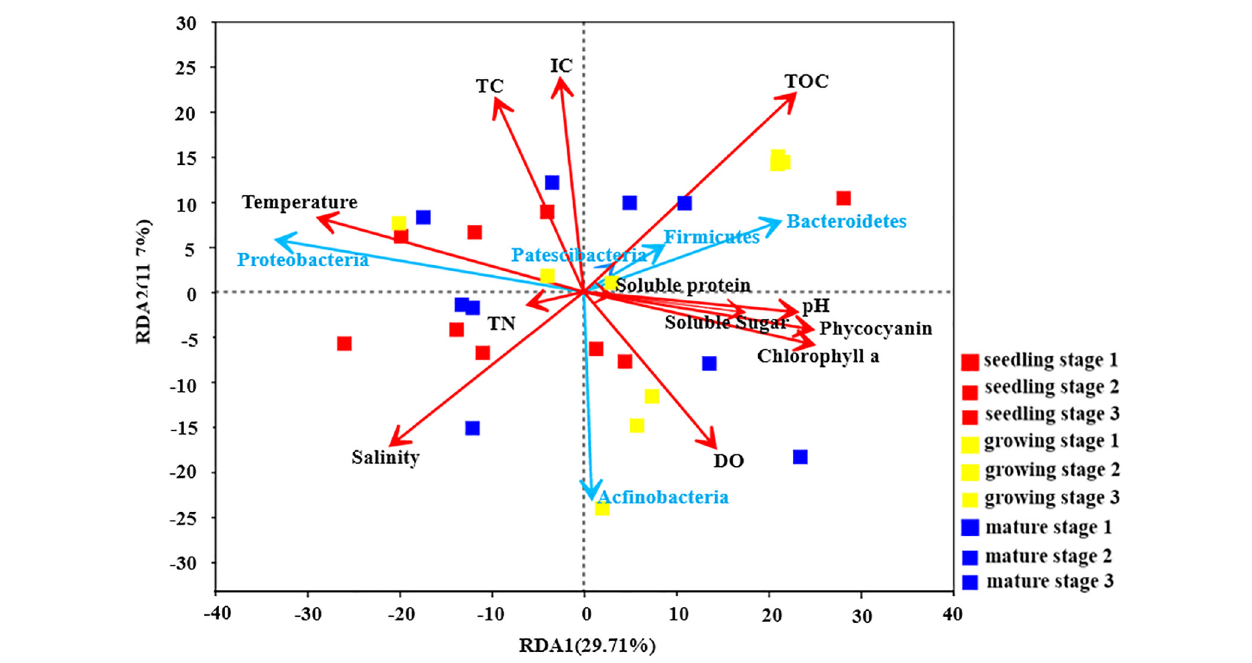
FIGURE 2 | Redundancy Analysis of U. fasciata surface microorganisms with environmental factors and plant physiological indexes at Phylum level (The red arrows represented different environmental parameters and physiological indicators of U. fasciata and the blue arrows represented the top five groups of bacteria in